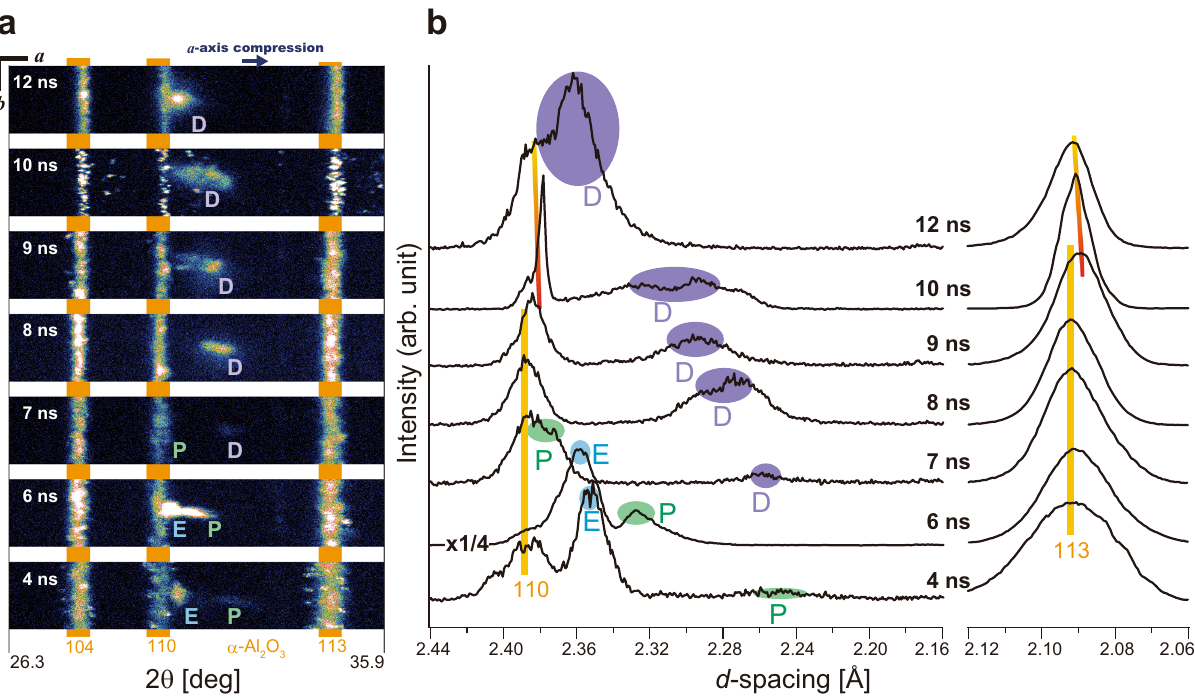
Fig. 2 XFEL diffraction results showing time evolution of g = 200 re fl ections from the polypropylene-olivine-Al 2 O 3 layered target. a Two dimensional images where each number represents the delay time t of an XFEL pulse from the power laser pulse arrival time to the surface of polypropylene. Diffuse spots marked ‘ E ’ , ‘ P ’ , and ‘ D ’ show the re fl ection from the oxygen layers of olivine in elastic and plastic shock wave regions, and re fl ection from its denser recrystallised region, respectively. Crystallographic orientations ( a and b ) are approximately shown for readability, together with the direction of a -axis compression. These axes are not necessarily precisely located on the detector plane. A vertical linear pro fi le within the three orange strips with the Laue indices shows Bragg re fl ections from the (104), (110), and (113) planes of polycrystalline Al 2 O 3 . b One dimensional patterns as a function of d obtained by the integration of the images. Positions of the peaks marked with E, P and D show d of their corresponding re fl ections, d 200 E , d 200 P , and d 200 D , respectively. At t = 4 ns, the d 200 P was compressed to 94 ± 1 % of d 200 1atm , which was comparable to the a -axis compression at static pressure of 60 to 100 GPa 57,58 . At t = 6 ns, the E and P peaks become much stronger due to the increase in volume of these compressed regions (the shown intensity pro fi le was reduced by a factor of 4). At t = 7 ns, the ‘ E ’ and ‘ P ’ peaks moved further to the left to become almost undetectable (see ‘ Methods ’ ), while the ‘ D ’ peak started to grow ( d 200 D = 2.25 − 2.26 Å, corresponding to d 222 of ringwoodite at 21 to 25 GPa). At t = 8 ns, the newly-emerged ‘ D ’ peak rapidly grew; it was also gradually shifting to the right ( d 200 D = 2.25 to 2.31 Å, corresponding to d 222 of ringwoodite at 6 to 25 GPa). At t = 9 ns, the re fl ections of Al 2 O 3 suddenly became slightly compressed, indicating that the shock wave had travelled throughout the olivine plate to arrive there. The strips with orange (not compressed) and red (compressed) colours are visual guides for the behaviour of these Al 2 O 3